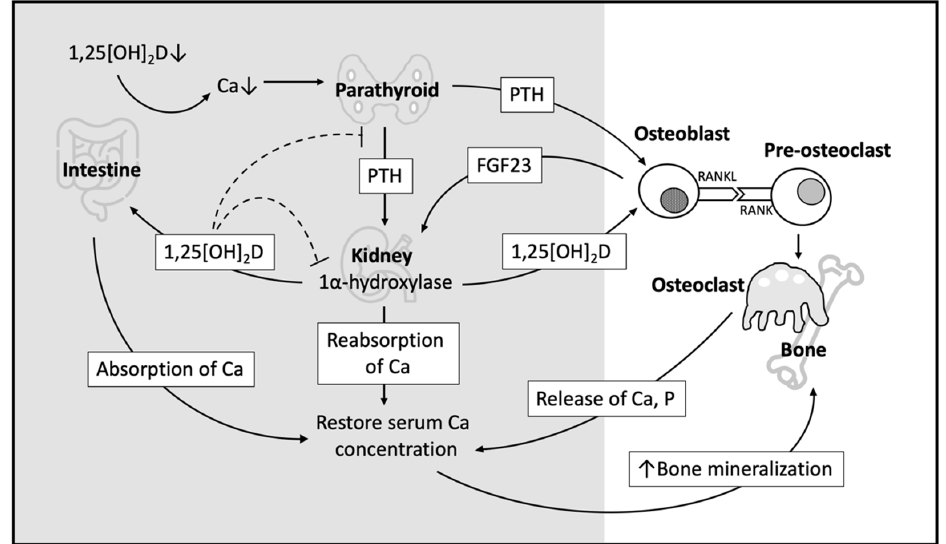
Figure 2. Role of vitamin D in bone metabolism. A low level of 1,25[OH] 2 D decreases calcium absorption in the intestines and results in a low level of serum Ca. The hypothyroid gland senses